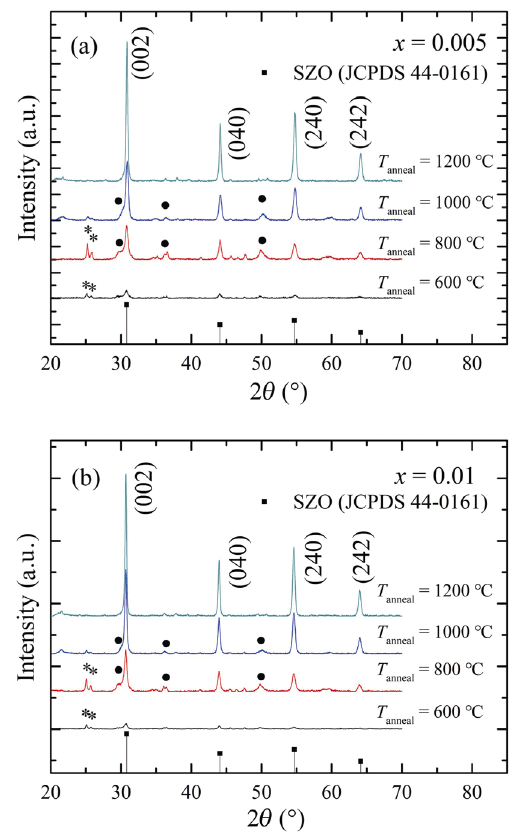
Fig. 1 X-ray diffraction ( θ –2 θ ) scans for (a) x = 0.005 and (b) x = 0.01 SZO:Er,Yb NCs annealed at T anneal ( T anneal = 600, 800, 1000, and 1200 ℃ ). The main peaks are indexed to the pseudo-cubic structure of SrZrO 3 (JCPDS 44-0161). The star and circle symbols indicate the peaks of SrCO 3 and ZrO 2 ,